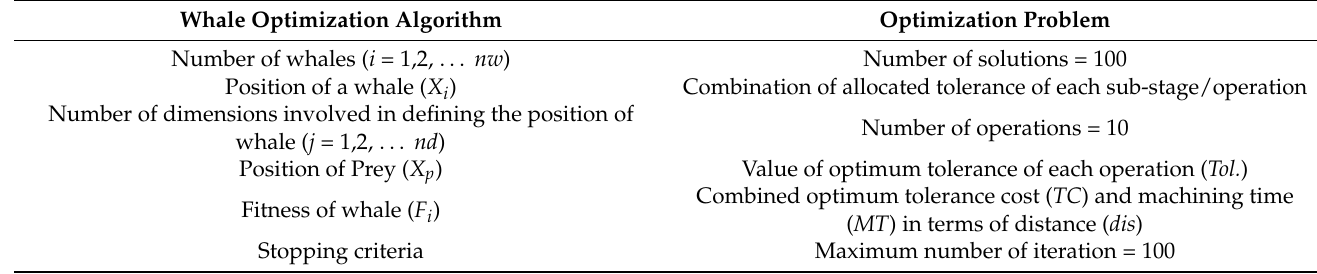
Table 10. Terms involved in whale optimization